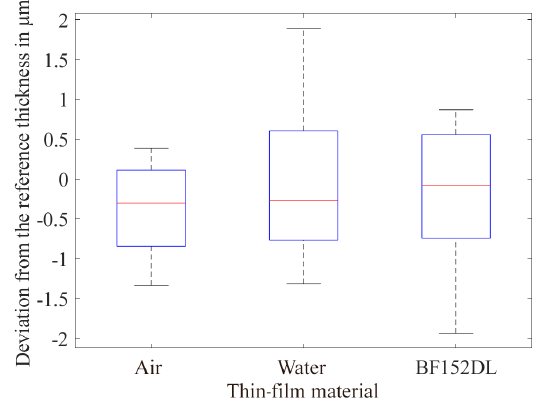
Figure 11. Deviations from the absolute layer thickness for air and water as the medium.